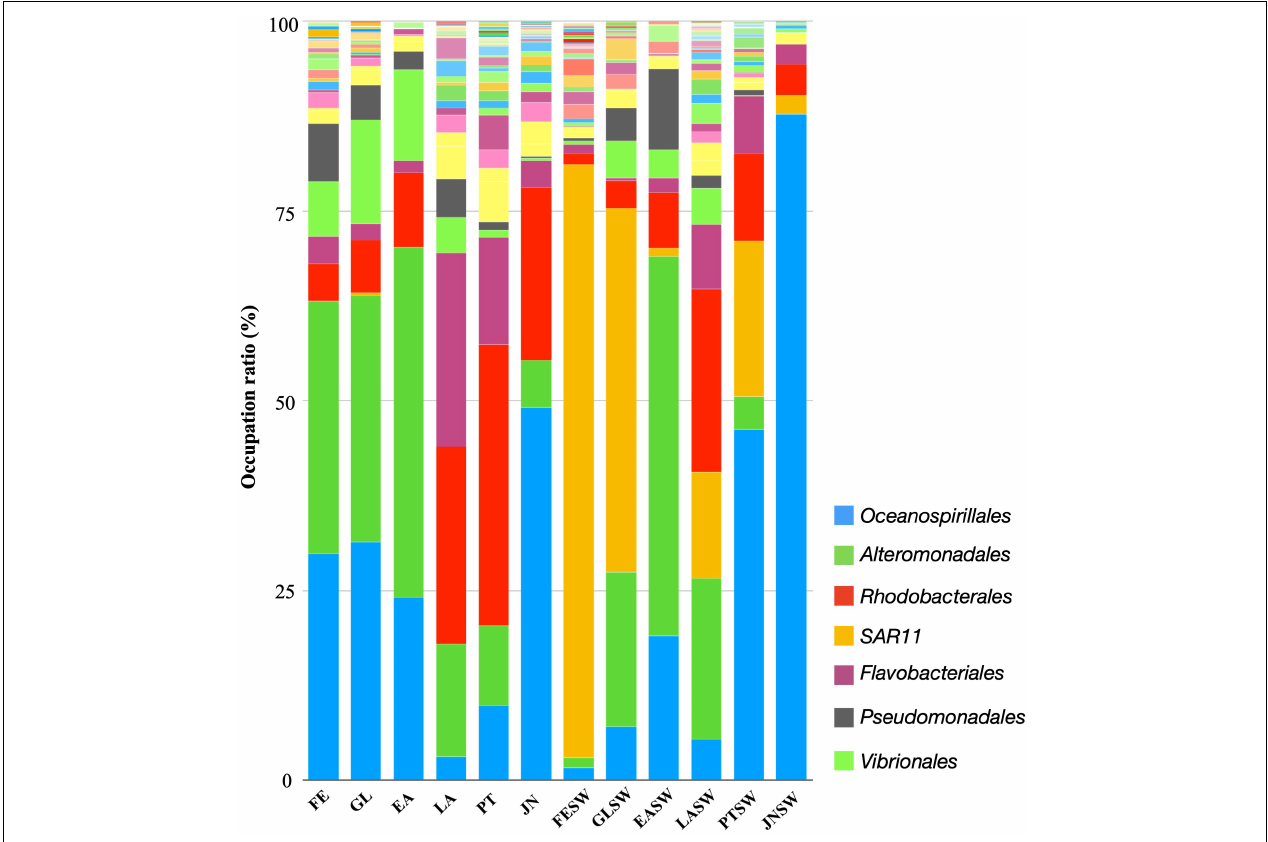
FIGURE 3 | Order-level taxonomic distribution among sea cucumber and seawater samples. Bars represent the relative percentage of each bacterial orders. FE, Fertilized egg; GL, Gastrula; EA, Early auricularia; LA, Late auricularia; PT, Pentactula; JN, Juvenile; FESW, Fertilized egg rearing seawater; GLSW, Gastrula rearing seawater; EASW, Early auricularia rearing seawater; LASW, Late auricularia rearing seawater; PTSW, Pentactula rearing seawater; JNSW, Juvenile rearing